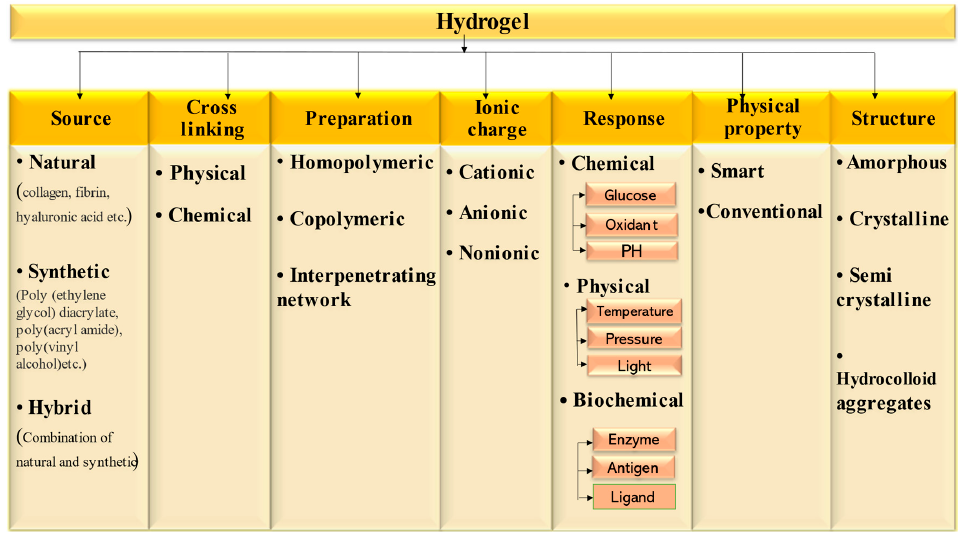
Figure 3. Classification of hydrogel-based